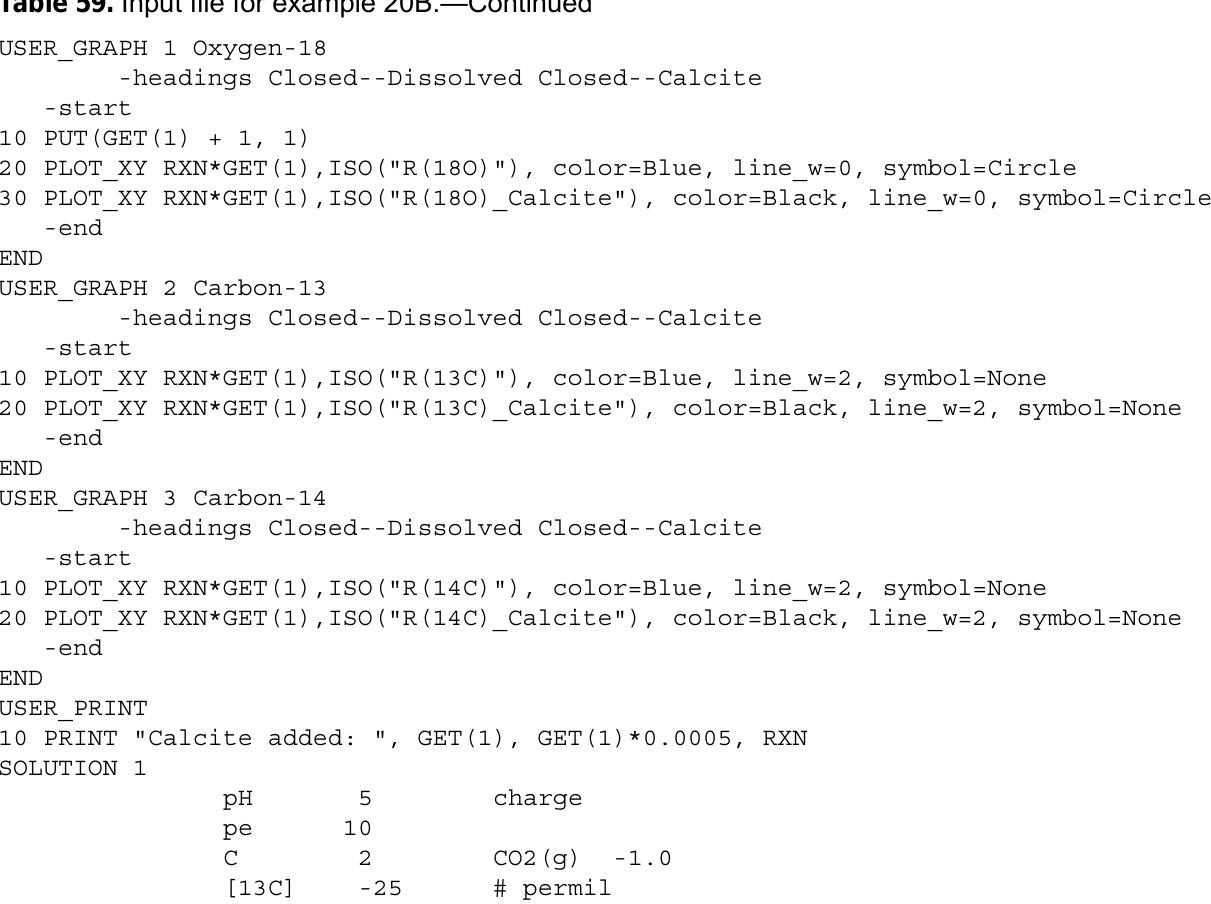
Table 59. Input file for example